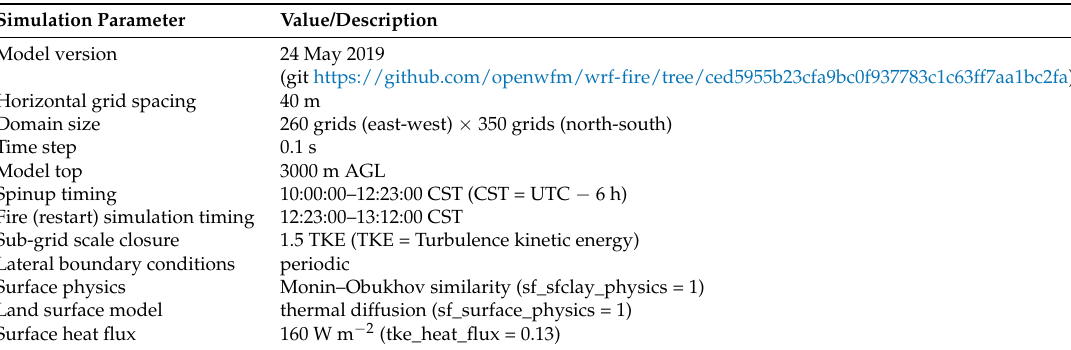
Table 1. Key parameters of numerical domain